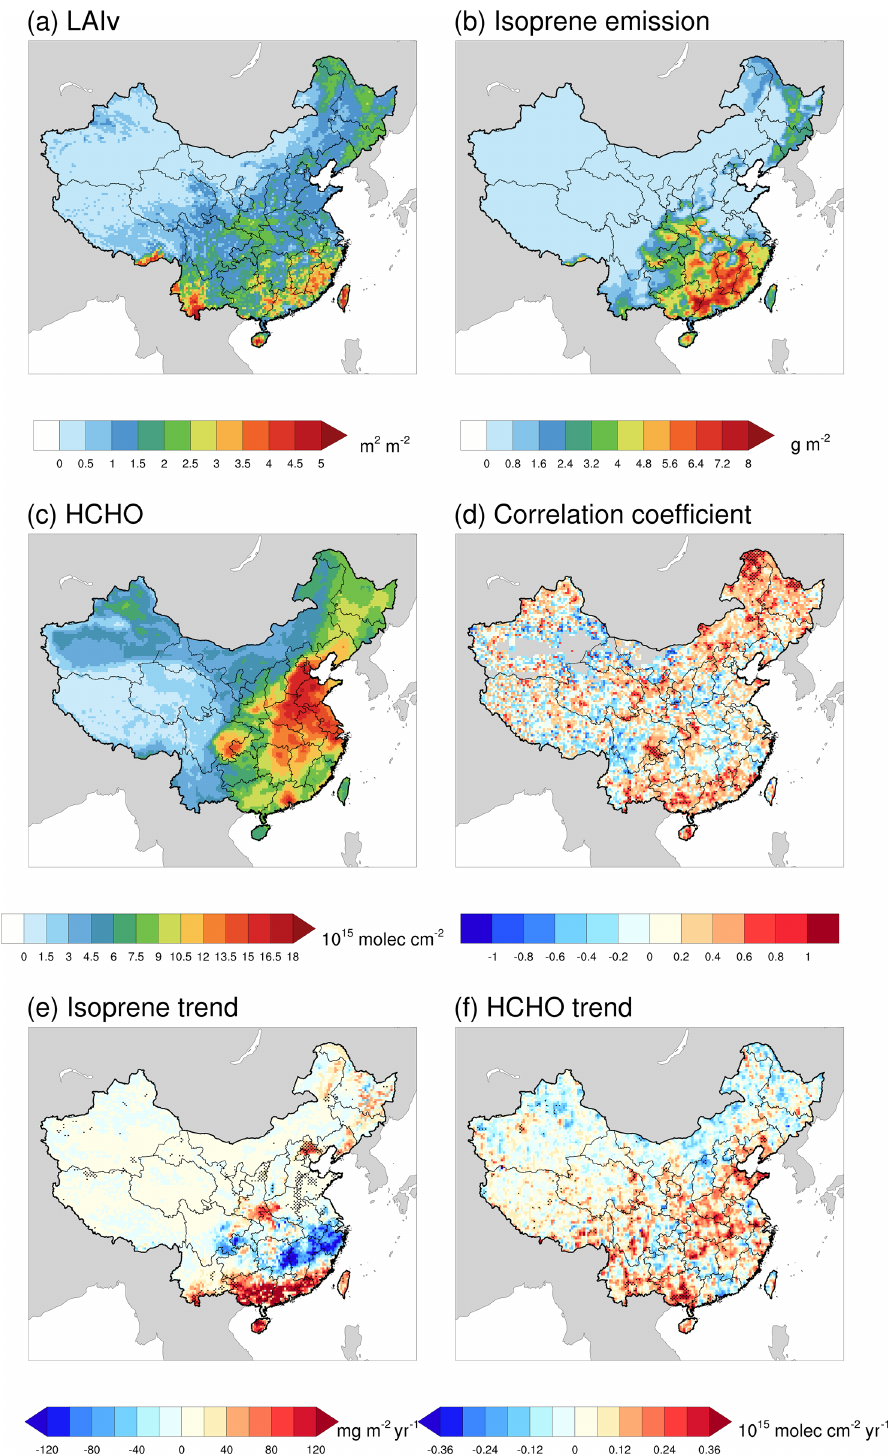
Figure 9. Comparison of estimated isoprene annual emission with the satellite-derived tropospheric HCHO vertical column concentration by OMI from 2005–2016. Panels (a) , (b) and (c) illustrate the spatial patterns of annual mean LAIv, isoprene emission and HCHO vertical columns (VC) by OMI, respectively. Panel (d) presents the spatial distribution of the correlation coefficient between summertime isoprene emission and HCHO VC. Panels (e) and (f) show the increasing trend of isoprene and HCHO VC from 2005–2016.